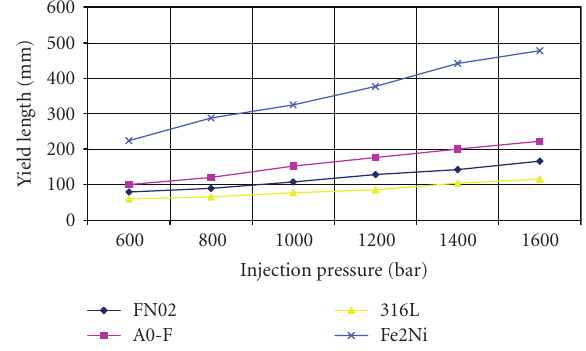
Figure 10: Yield length versus pressure graph for feedstocks.